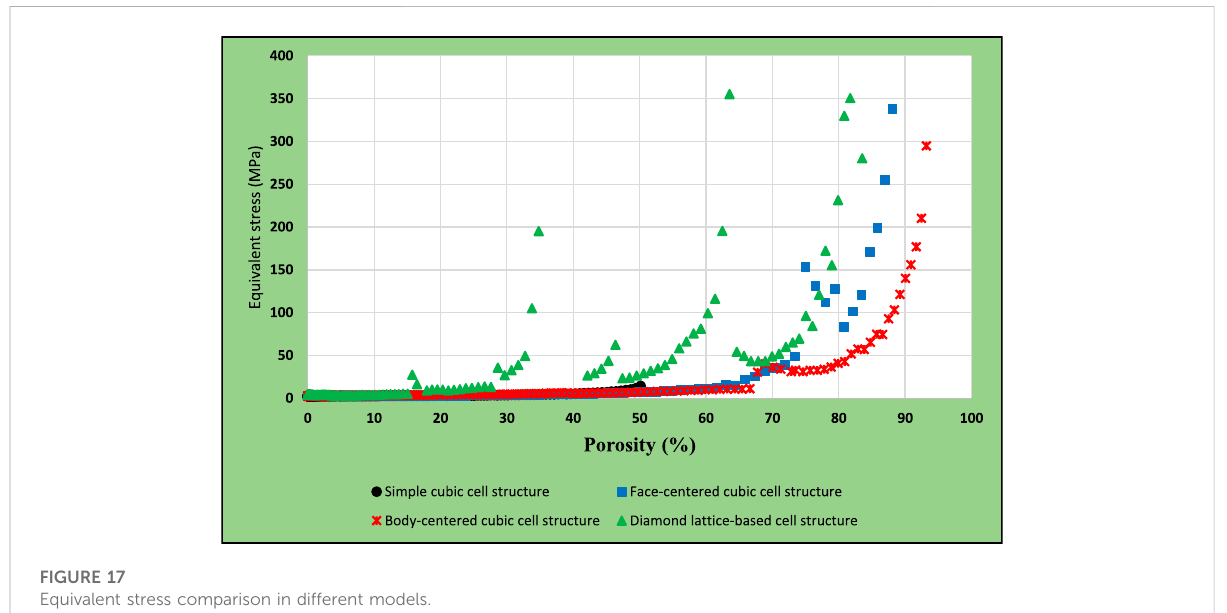
FIGURE 17 Equivalent stress comparison in different models.